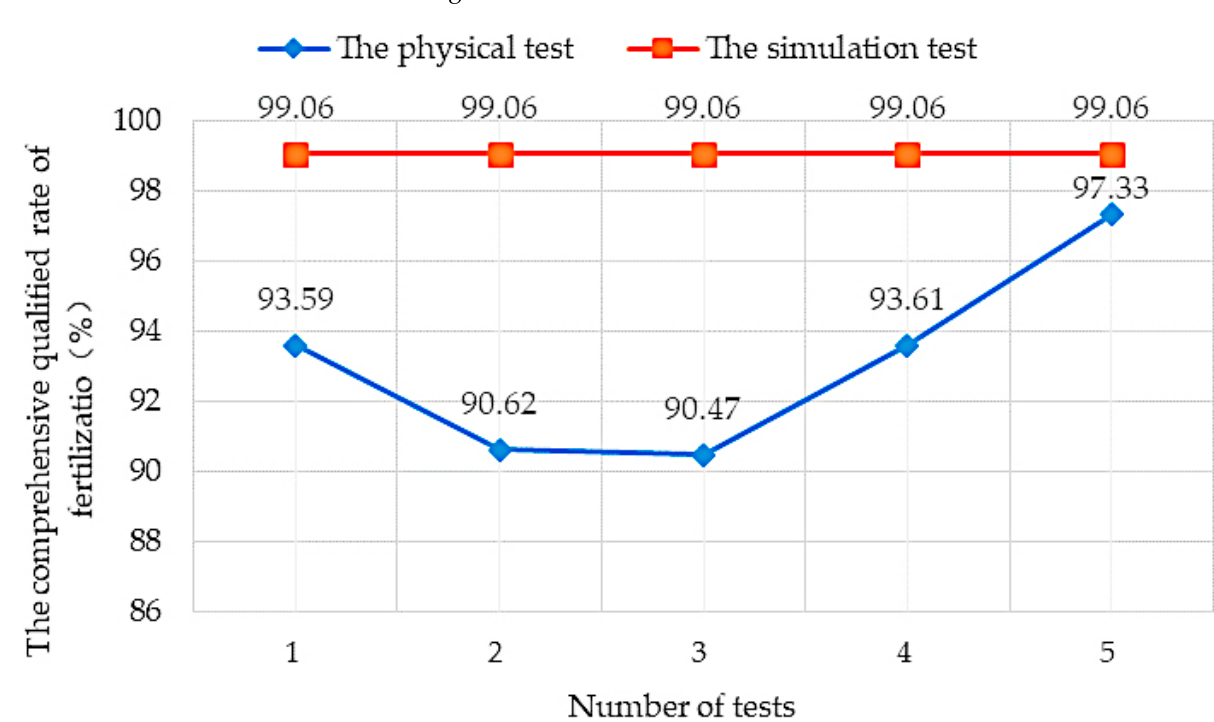
Figure 9. Comparative analysis of physical experiment and simulation experiment